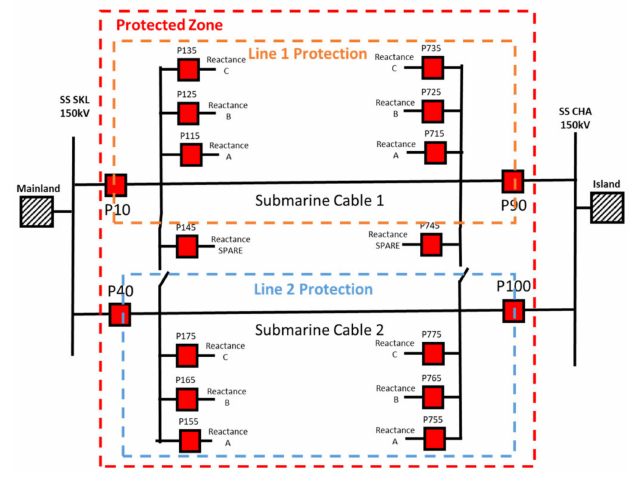
Figure 18. Reactive compensation: four reactors connected. (b) Scenario 2: Two reactors are connected (see Figure 19).